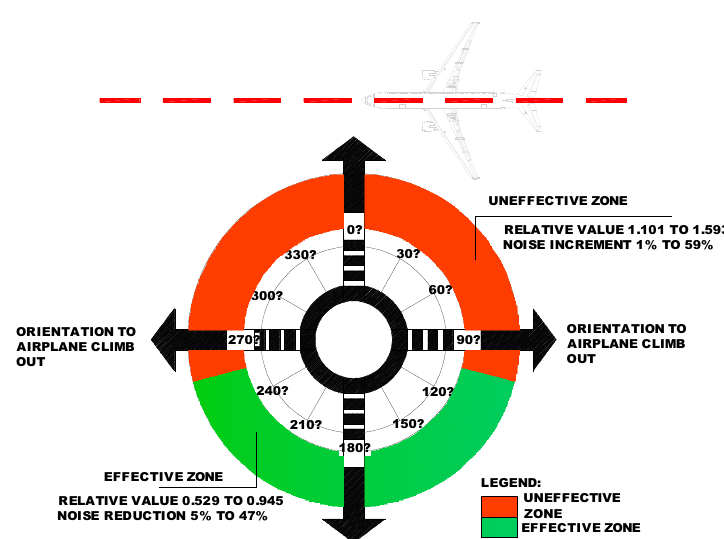
Figure 6. Building Orientation mapping to runway.